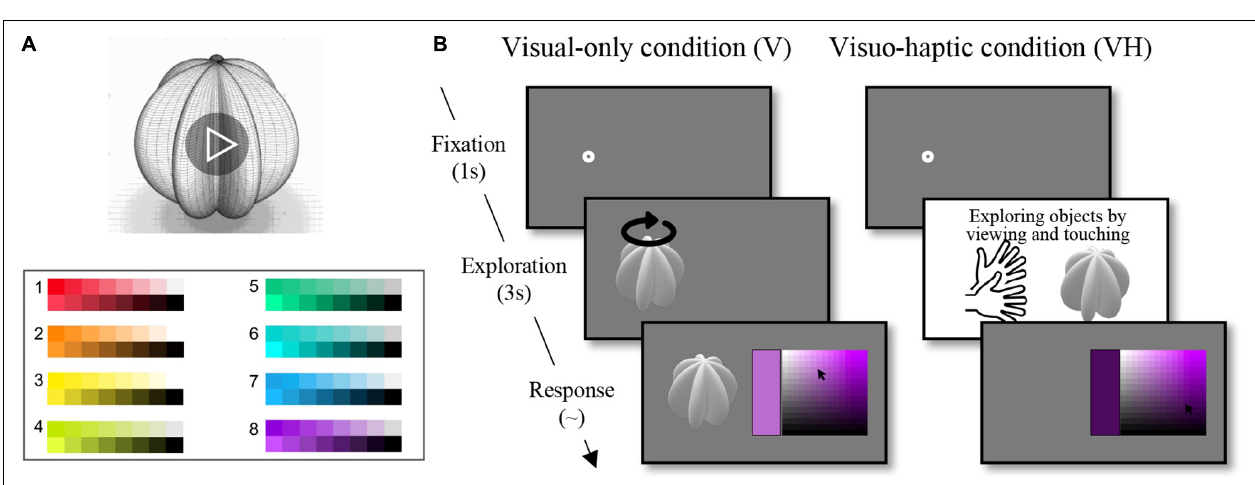
FIGURE 2 | Procedures in Experiments 1 and 2. (A) Participants watched each of the nine video clips panning an achromatic 3D shape for 3 s and chose from eight hue palettes which hue they thought best matched the shape. (B) 1s fixation was followed by 3 s of a video clip in the visual-only condition and by 3 s of viewing and exploring a 3D shape object in the visuo-haptic condition. After the exploration, participants were presented a palette manipulated in luminance and saturation dimensions for a hue and chose the color they thought best matched the shape.